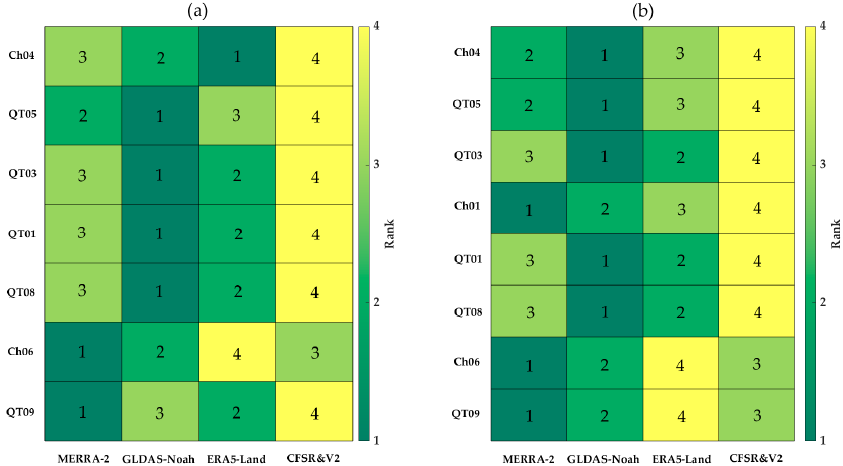
Figure 6. Comprehensive model ranking in four reanalysis products. 10 cm ( a ), 50 cm ( b ). Rank 1 represents the best-performing model, indicating high applicability. (Missing 10 cm records at Ch01 site due to equipment failure.)